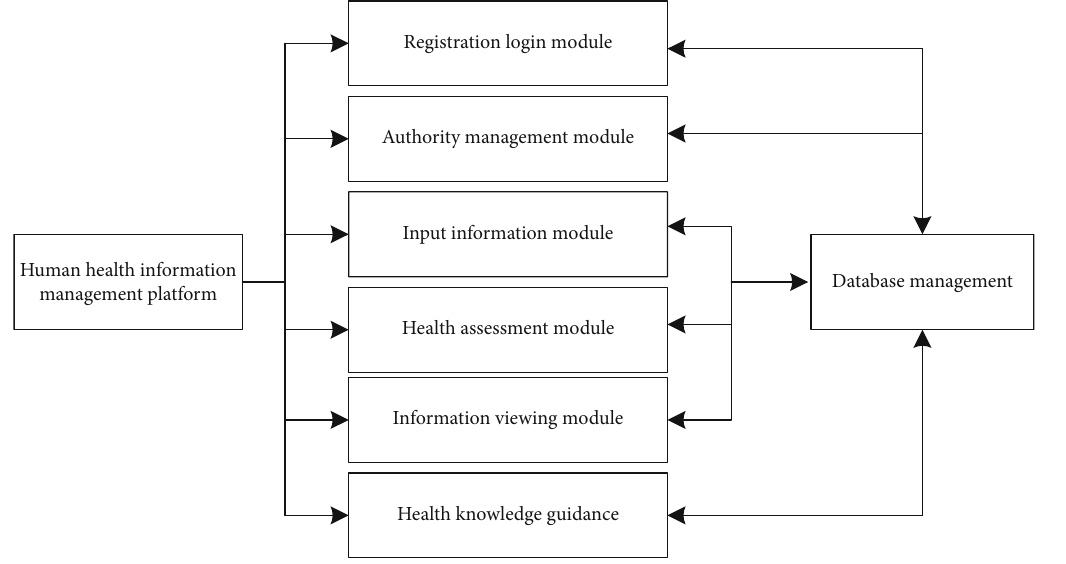
Figure 3: Health information management